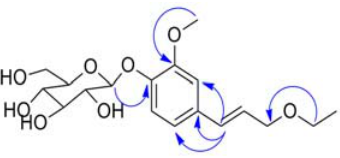
Figure 2. Key HMBC correlations in compound 1 .